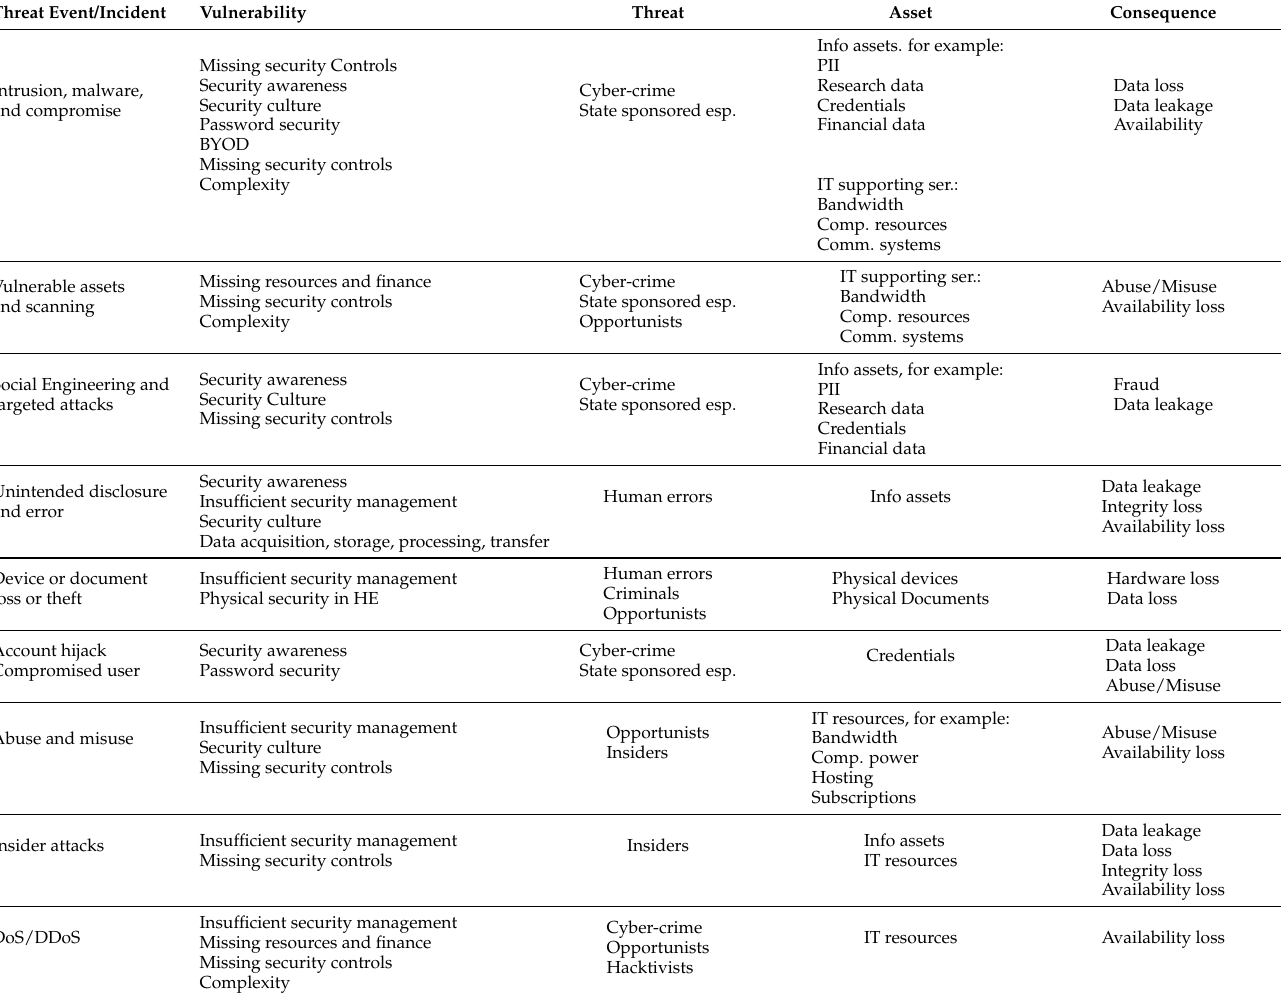
Table 16. Vulnerability, threat, asset, and consequence analysis of the top threat